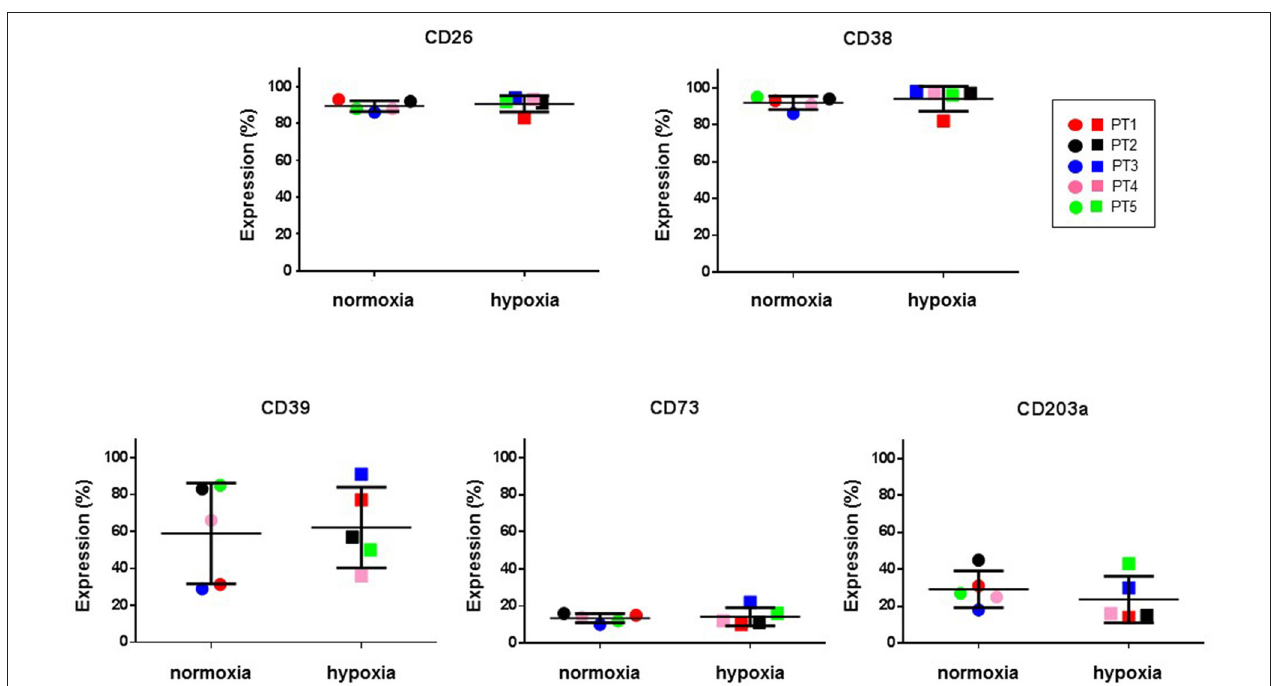
FIGURE 6 | Expression of ectoenzymes in CIK cells under normoxic and hypoxic conditions. Comparative cytofluorimetric analysis of CIK cells stained with primary antibodies to various ectonucleotidases as reported in Materials and Methods. To compare hypoxia and normoxia we used unpaired nonparametric test, two-tailed Mann-Whitney for GraphPad Prism 6. Circles, normoxia; squares, hypoxia. Patients are as following: PT1, red; PT2, black; PT3, blue; PT4, pink; PT5, green. Reported data are expressed as mean values ± SD.